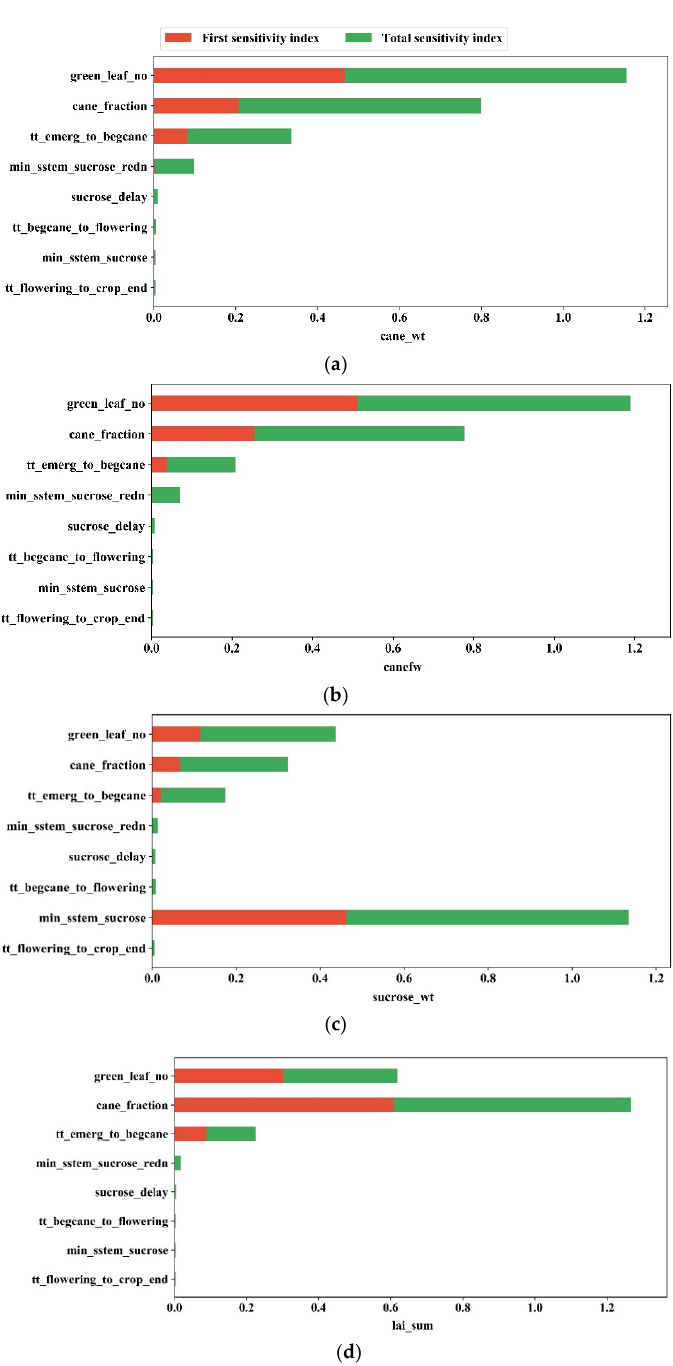
Figure 6. The first and total sensitivity indices for the four outputs to eight cultivar parameters in the APSIM sugarcane model. ( a – d ) Stacked bar graphs of two sensitivity indices of cane_wt, canefw, sucrose_wt, lai_sum, respectively.